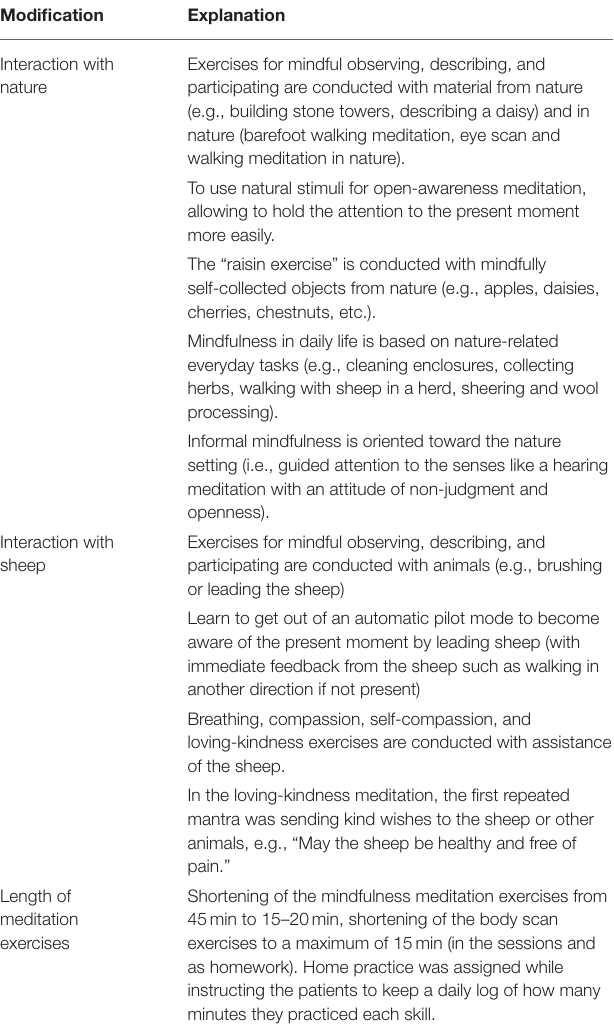
TABLE 1 | List of modifications to the conventional MBCT